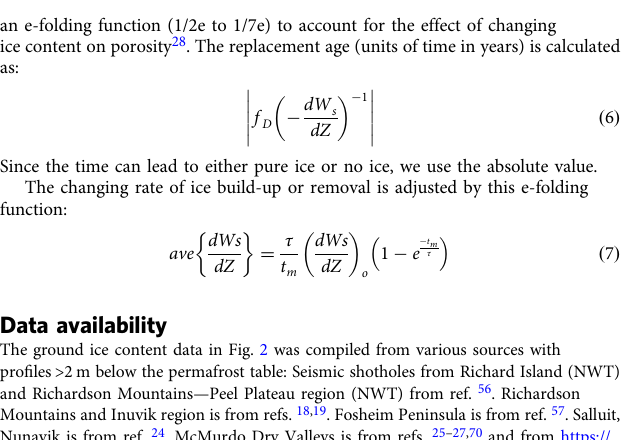
Fig. 7 Replacement age of ground ice in various sediments and soil water chemistries. Table 3 lists values used in the WATEREGO ensemble simulations. The replacement age is calculated as the inverse of the derivative of the net water speed with depth and adjusted by an e-folding function (1/2e to 1/7e) to account for the effect of changing ice content on